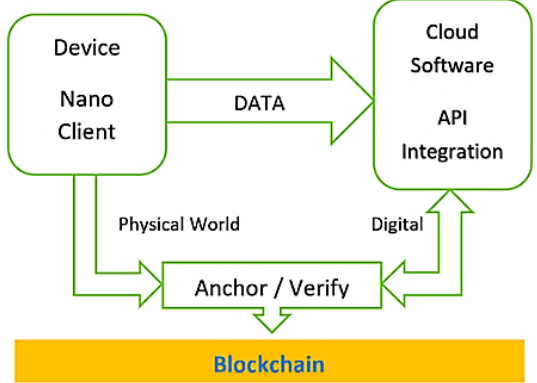
Figure 26. UBIRCH Chain of Trust application structure diagram (Ubirch).